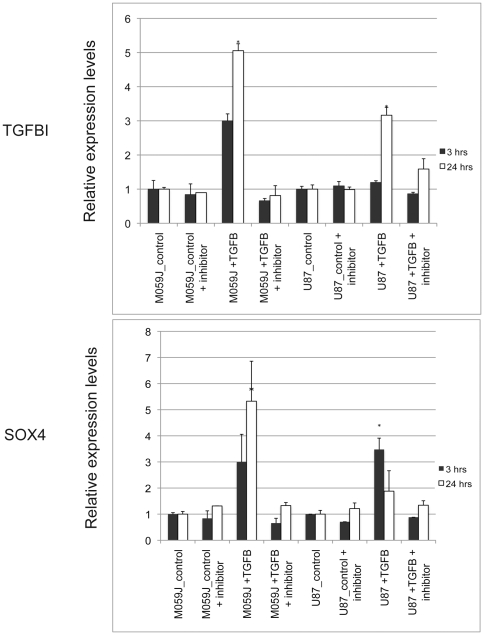
RT-PCR results showing the expression changes of TGFBI (GENE ID:7045) and SOX4 in response to TGF−β stimulation with and without inhibition of TGF−β receptor I (TβRI) kinase in two GBM cell lines, M059J and U87MG.Y-axis indicates relative expression levels with standard deviation indicated on top of the each bar. X-axis indicates cell types and treatment conditions (vehicle control, vehicle control plus TβRI kinase inhibitor LY210976, TGF−β stimulation, TGF−β stimulation in the presence of TβRI kinase inhibitor LY210976). The expression levels of TGFBI (GENE ID:7045) and SOX4 were measured at two time points 3 hours and 24 hours (* indicates P<0.05, T test, two-tailed distribution, unequal variance).